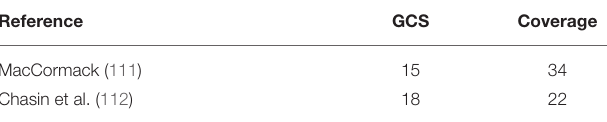
TABLE 7 | Citing papers belonging to cluster #3.